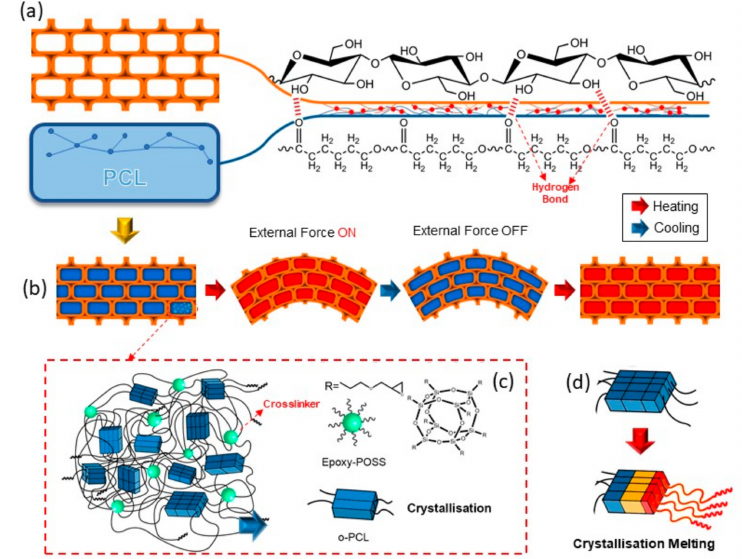
Figure 4. Schematic illustration showing the combination mechanism of shape memory wood. ( a ) Schematic to illustrate the combination between wood and PCL, which depicts the generation of hydrogen bonding between -OH and C = O. ( b ) Graphical depiction of SMW deformation process under external force at heating and cooling condition. ( c ) Graphical illustration of covalent cross-linking structure between o-PCL chains and depiction of crystal distribution that endows SMW transition temperature and rigid fixation. ( d ) Graphical depiction of crystallization melting